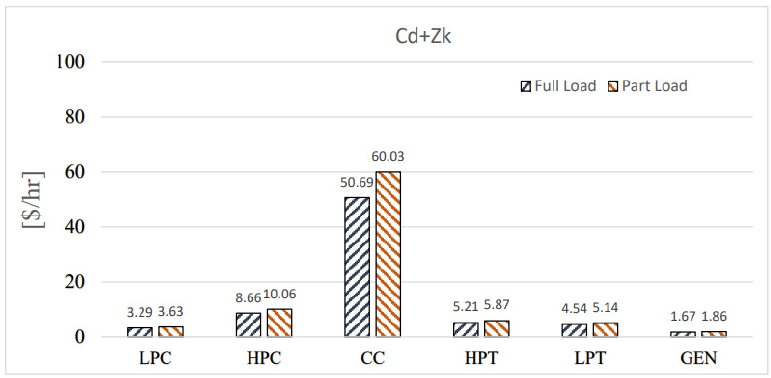
. . T C d + Z k ) for GT engine (Axial-centrifugal compres-